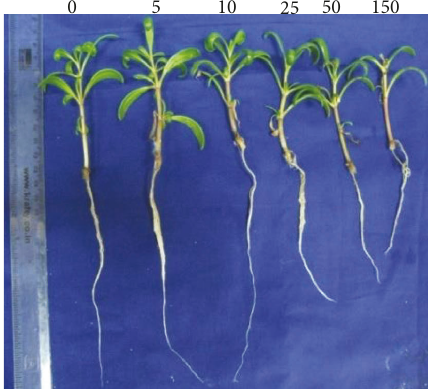
Figure 1: Effect of cesium on the growth of S. portulacastrum . Plants were subjected to different concentrations of Cs (0, 5, 10, 25, 50, and 150mg · L − 1 ) and harvested after 28 days of treatment for growth analysis.